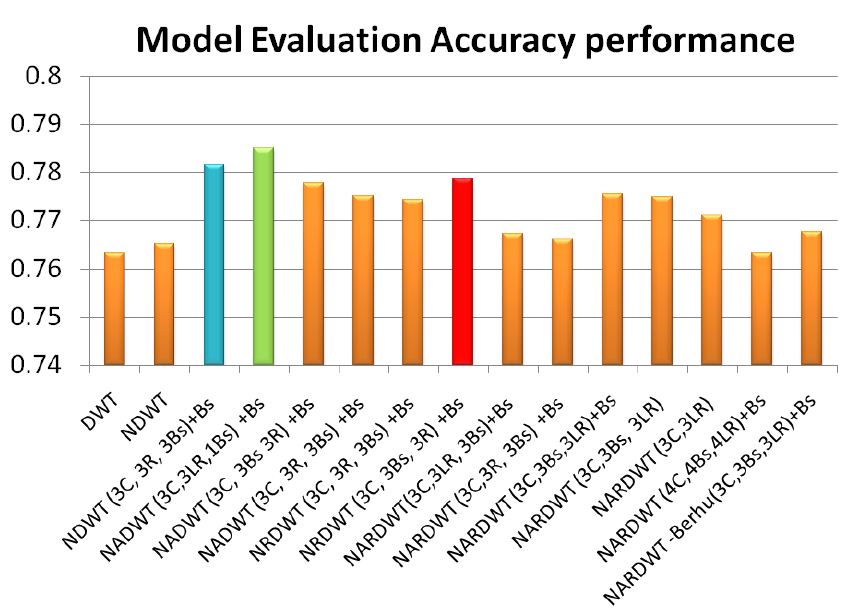
Figure 13. Model evaluation accuracy